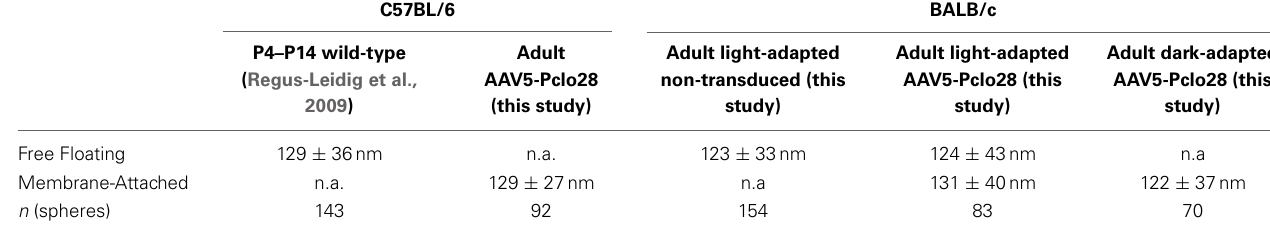
Table 1 | Mean diameter of spherical ribbon profiles.